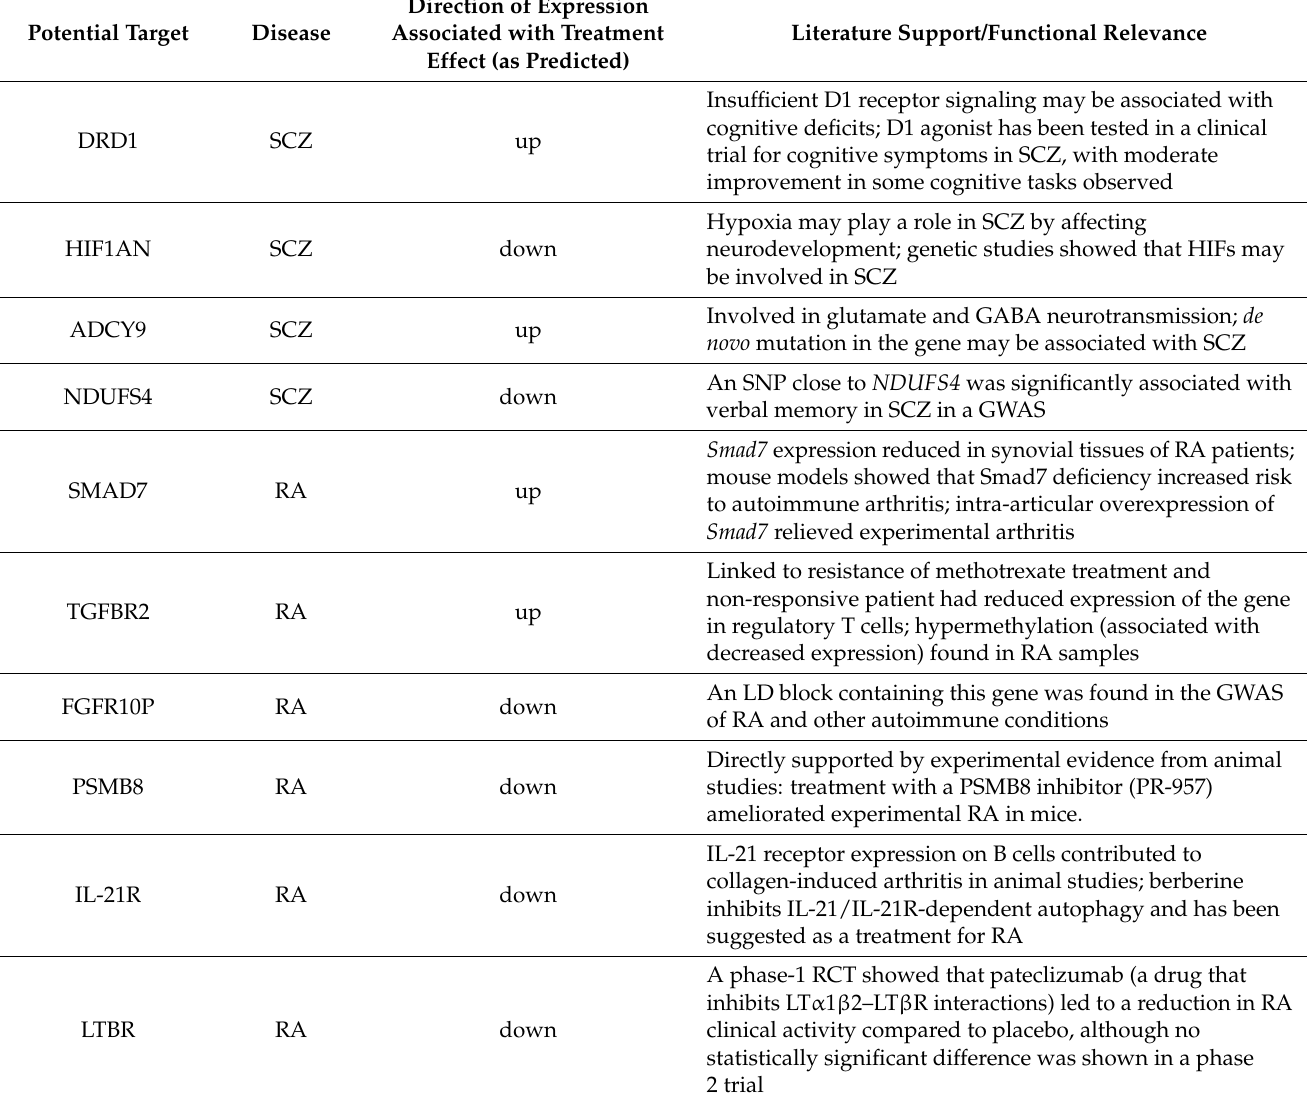
Table 6. Literature support of selected drug target